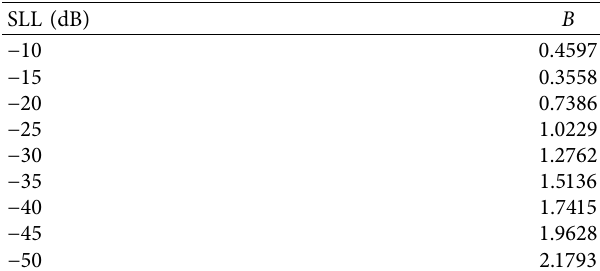
Figure 1: The relation between the excitation amplitude and the distance between the array elements [2, 17]. Table 1: The value of constant B in Taylor one-parameter distri- bution characteristic.